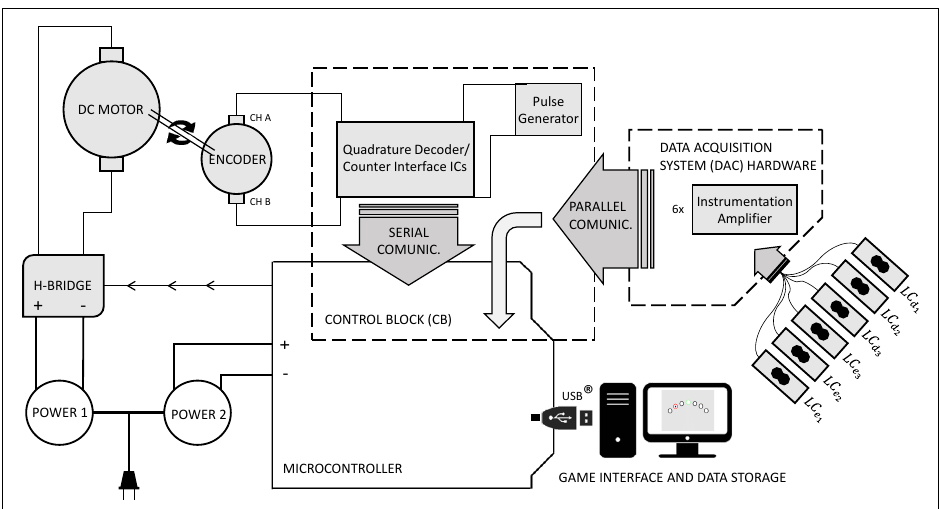
Figure 2. Schematic diagram of the system hardware. The Data Acquisition System includes the instrumentation amplifiers and the loadcells (LC), while the Control Block comprises the ICs for the decoder and count of the quadrature encoder. In order to avoid electrical interference, different power sources were used for the motor and for the